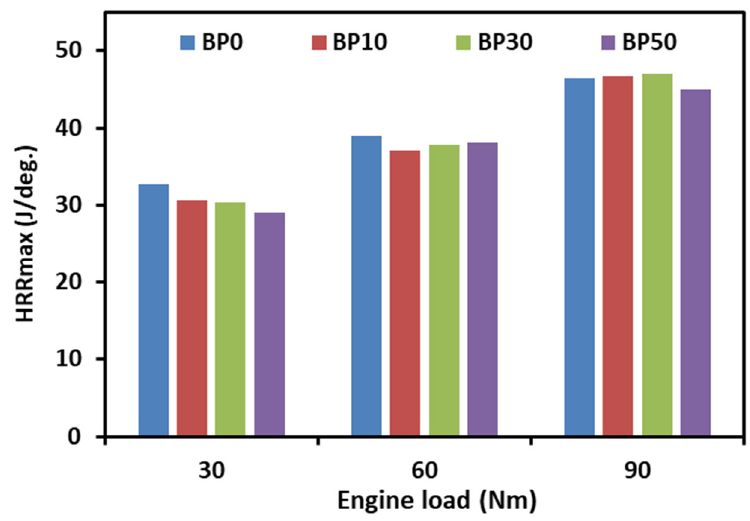
Figure 5. Maximum heat release rate for all test fuels according to various engine